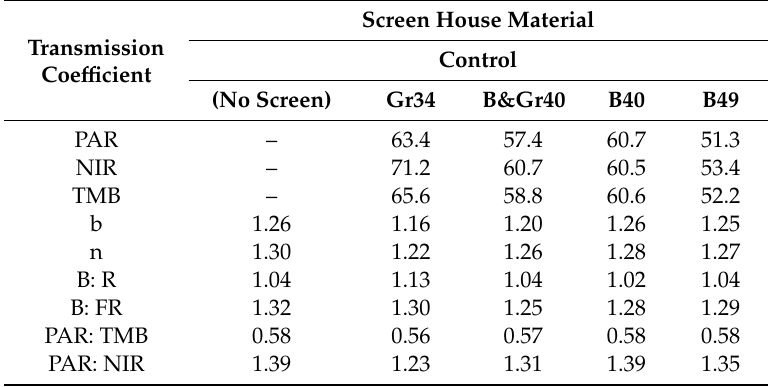
Table 2. Impact of plastic shade netting on optical properties